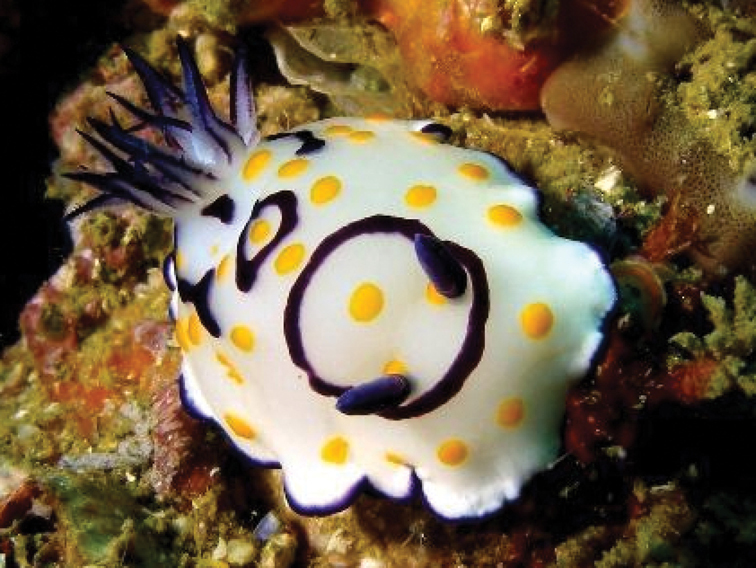
Chromodoris annulata, Persian Gulf, photo: S Kahlbrock (no spcm).